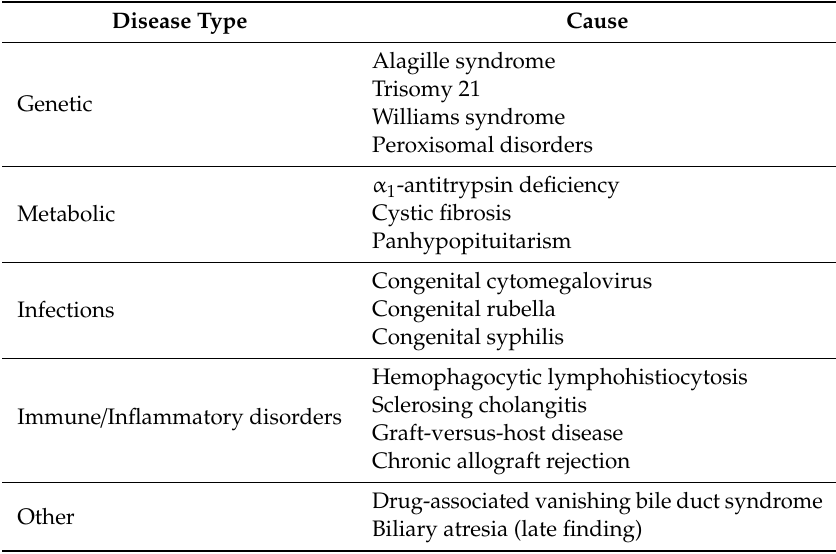
Table 1. Di ff erential Diagnosis of Bile Duct